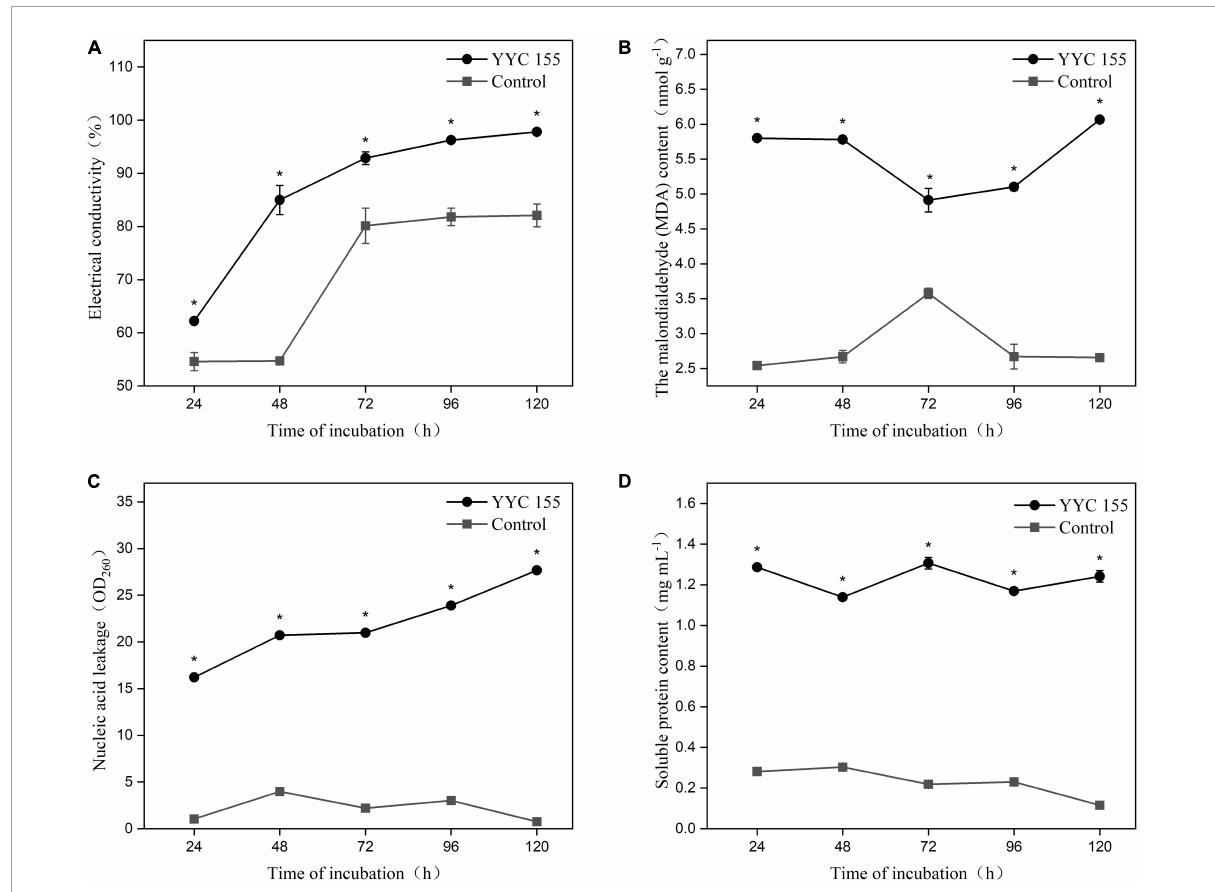
FIGURE5 Effect of strain YYC 155 on cell membrane permeability and the content of cellular compounds in C. fructicola. (A) Electrical conductivity; (B) the malondialdehyde (MDA) content; (C) nucleic acid leakage; (D) soluble protein content. Three duplicates are used for the control and YYC 155 treatment against C. fructicola at each time point and were measured three times for each replicate. Data represent the mean ± standard error (se). Asterisks indicate a significant difference between the control and YYC 155 treatment groups at the designated time point as determined by the t -test ( P < 0.05).